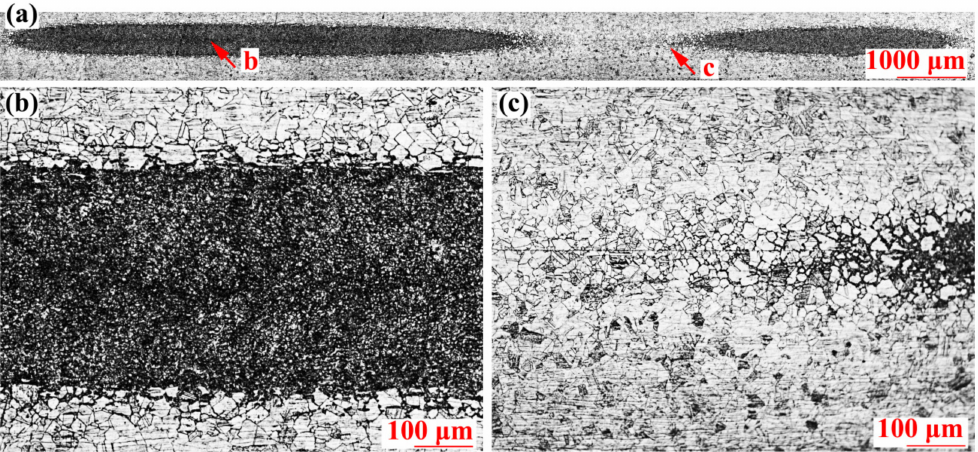
Figure 13. Metallographic morphology of nugget on the (The welding pressure is 6.5 kN): ( a ) overall perspective, ( b ) morphology on the nugget left side, and ( c ) morphology on the heat a ff ected zone in the center.